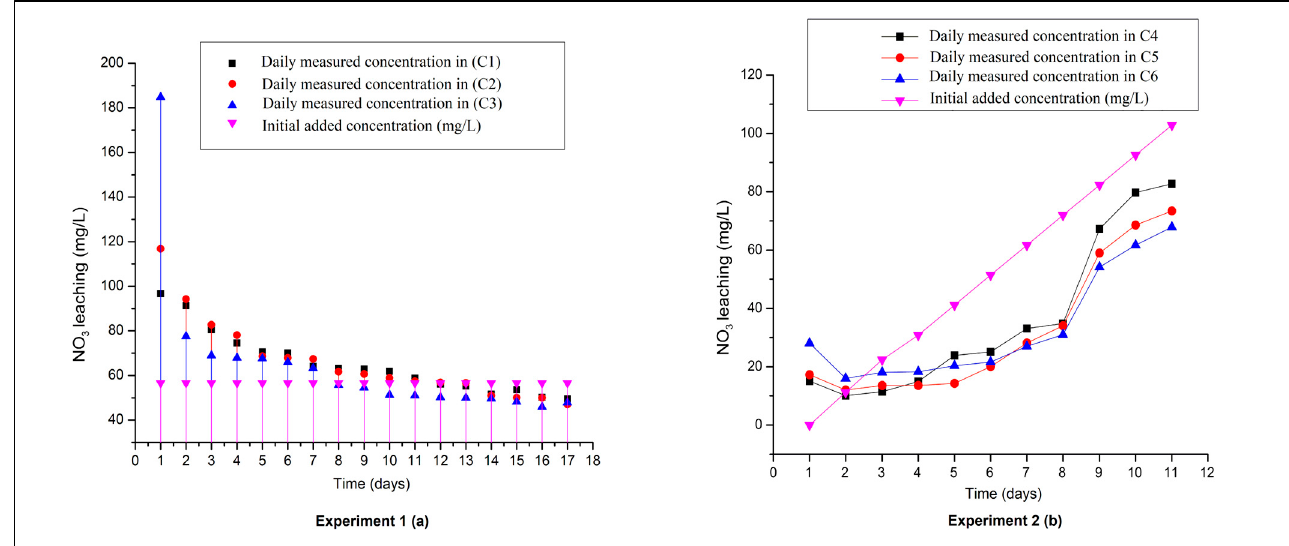
Figure 4. NO 3 − leaching from experiment 1 ( a ) and experiment 2 ( b